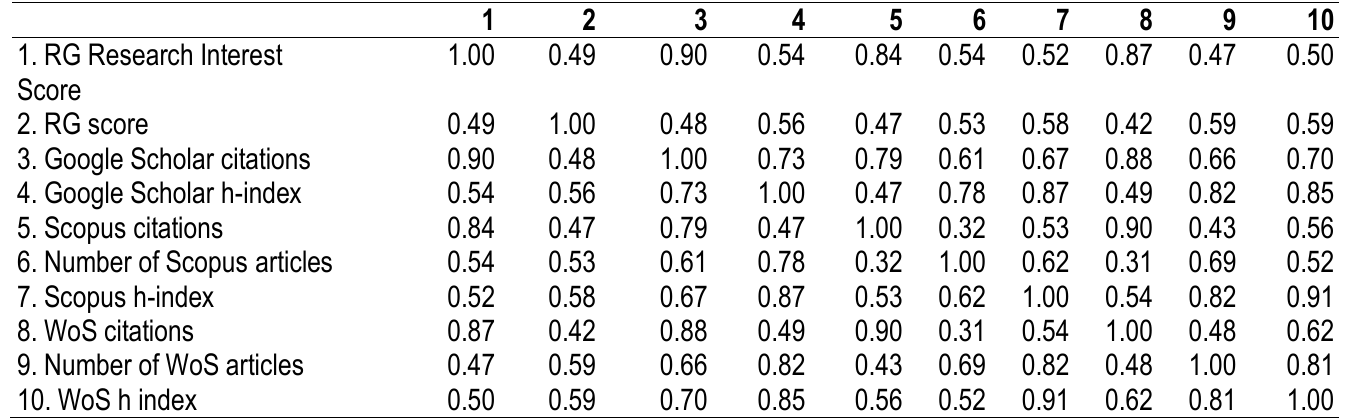
Table 1. Pearson correlation coefficients between scientometric indices for 88 scholars from the University of Sarajevo